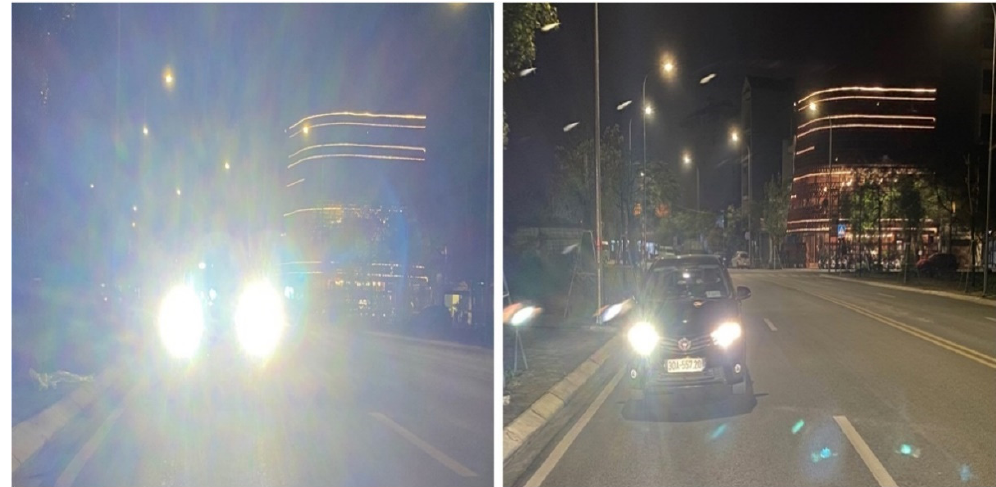
Figure 2. Pictures of LED headlights with ( right ) and without ( left ) polarizing filters.